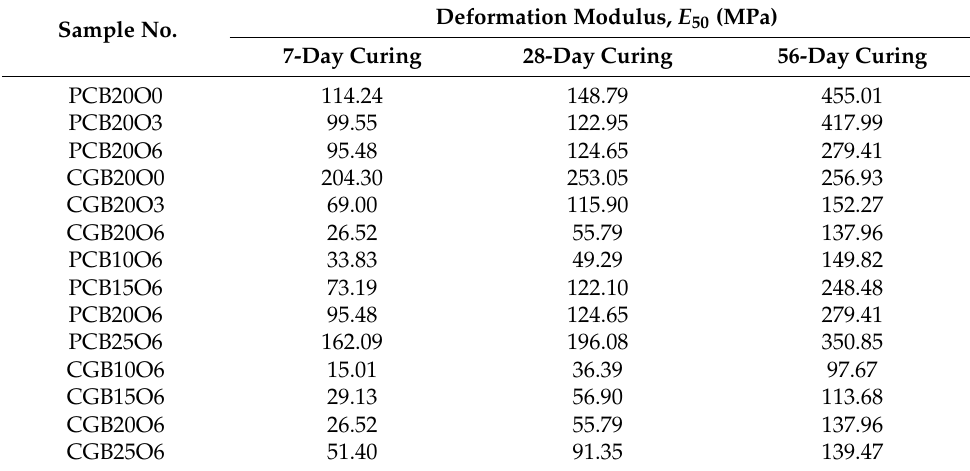
Table 4. The deformation modulus ( E 50 ) of CG/PC-stabilized specimens. Sample